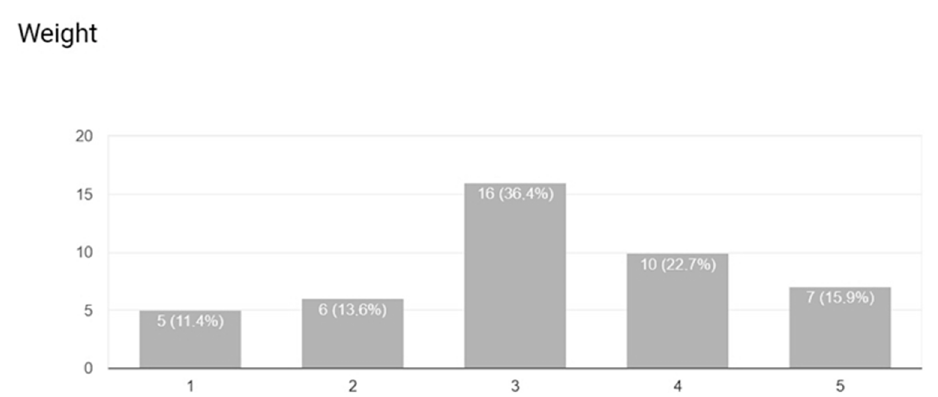
Figure 4. Example of data analysis .